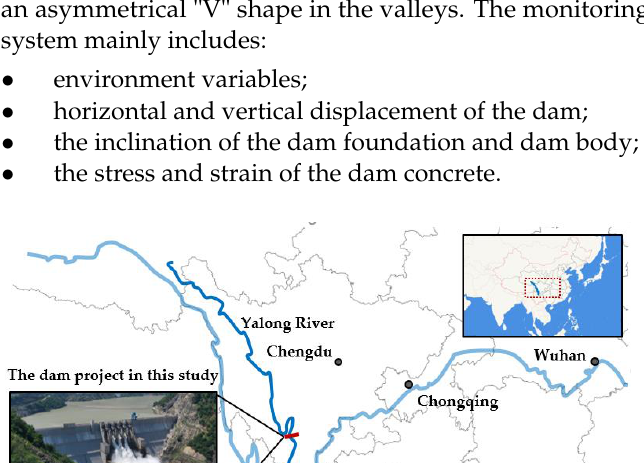
9 of 20 2.4. Evaluation Metrics The root mean square error (RMSE) and average absolute percentage error (MAPE) are frequently used as evaluation indicators of the regression model, computed as Equa- tions (14) – (15). is the i -th predicted value; N is the number of data. Given that RMSE is measured in the same units as the target variable, MAPE is measured in the relative percentage of error; these provide a practical accuracy evaluation. Moreover, the average relative variance (ARV) adopts as a measure of accuracy in this study [30]: o y is the mean of the observed data. Given that ARV represents the ratio be- tween the mean squared error and the variance, it considers both the magnitude and the deviation of the target variable. Furthermore, a model with ARV = 1 is as accurate an es- timate as the mean of the observed. 3. Case Study 3.1. Project Description An engineering project in southwestern China contains the water retaining structure,